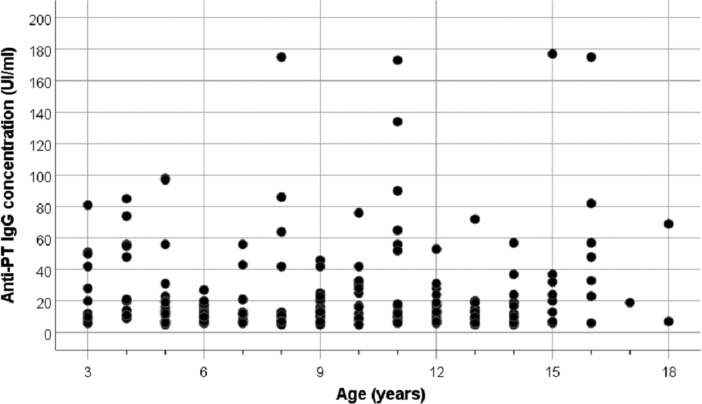
Distribution of anti-PT IgG levels according to age.